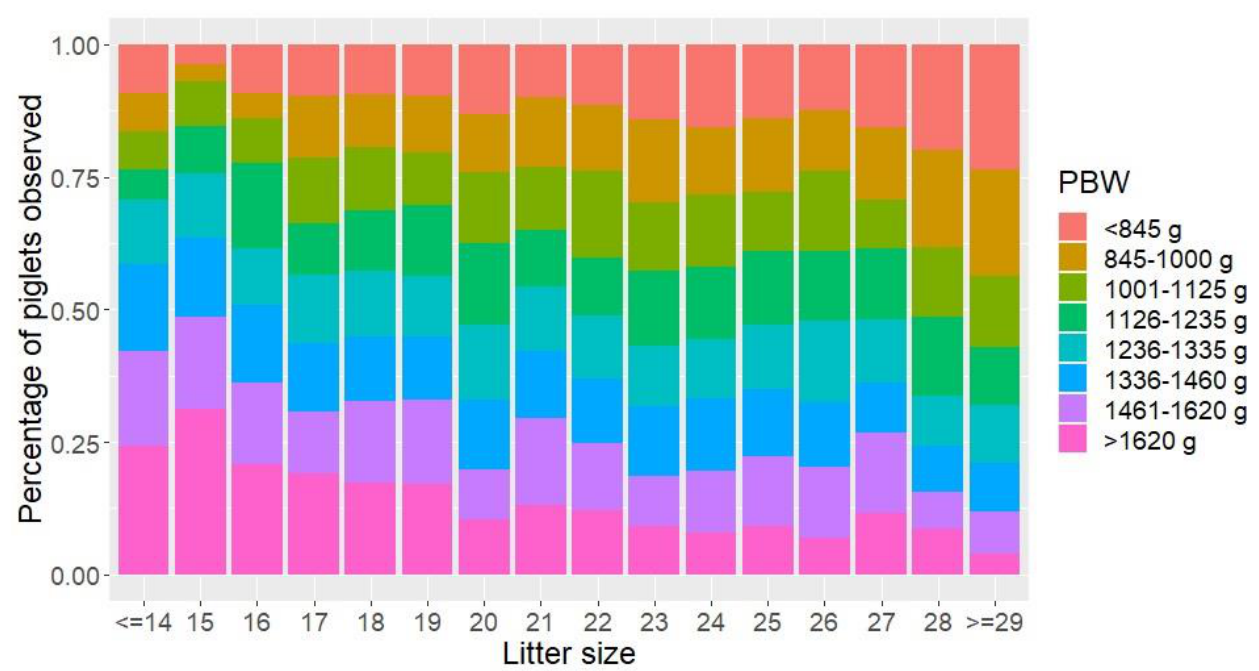
Figure 5. Percentage of liveborn piglets in different piglet birth weight (PBW) categories, showed by different colors, with increasing litter size across parities. The weight categories are based on quartiles, so there is an equal number of piglets in each PBW category.